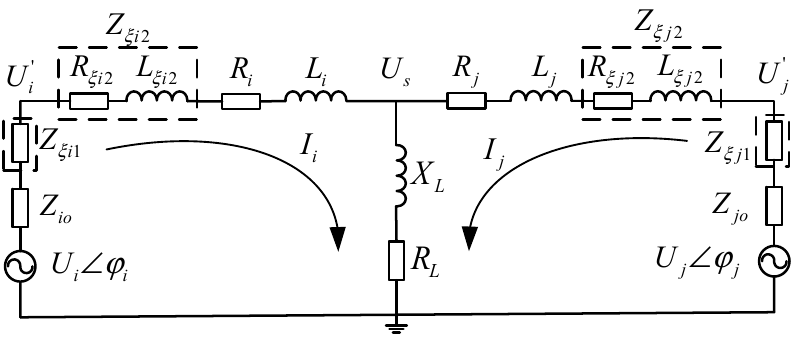
Figure 3. Topology of two parallel DERs.